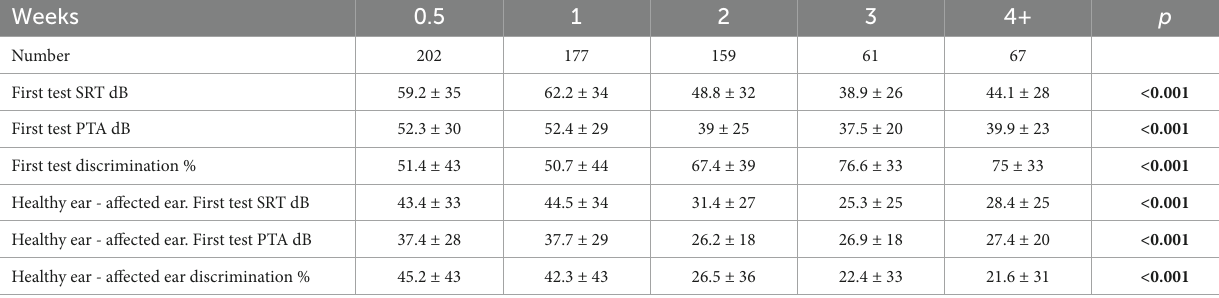
TABLE 2 Primary audiometry results according to treatment initiation time in weeks from symptom